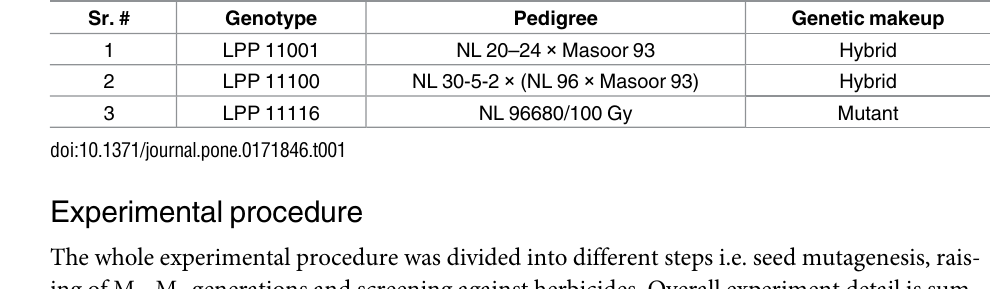
Table 1. Description of lentil genotypes used in present